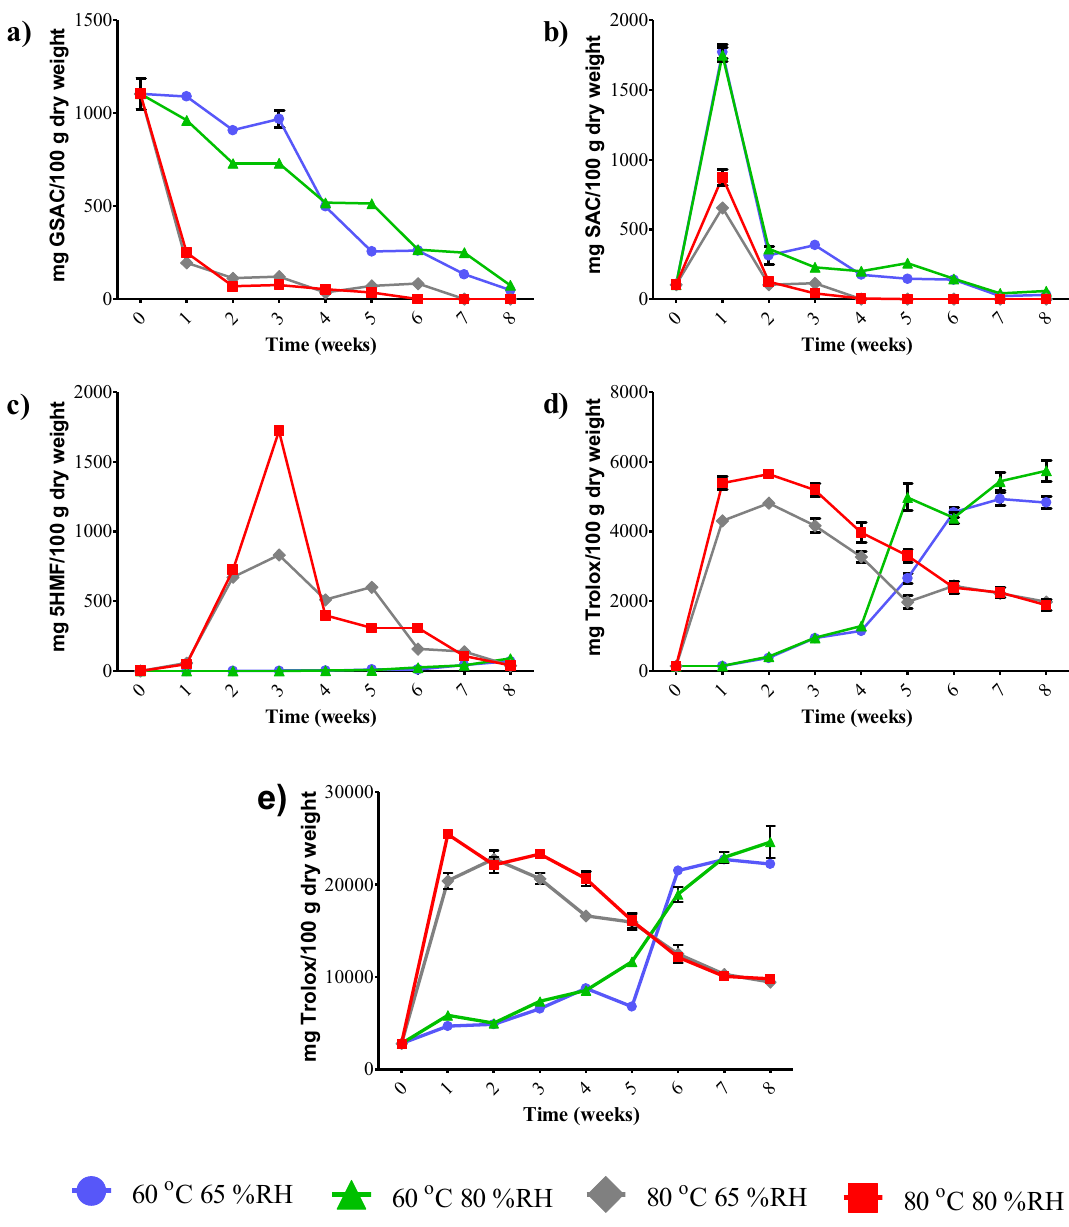
Figure 1. GSAC content ( a ), SAC content ( b ), 5-HMF content ( c ) and antioxidant activities by DPPH assay ( d ) and ABTS assay ( e ) of black garlic after different thermal processes at various temperatures and relative humidity; error bars represent standard deviations of the mean (n =